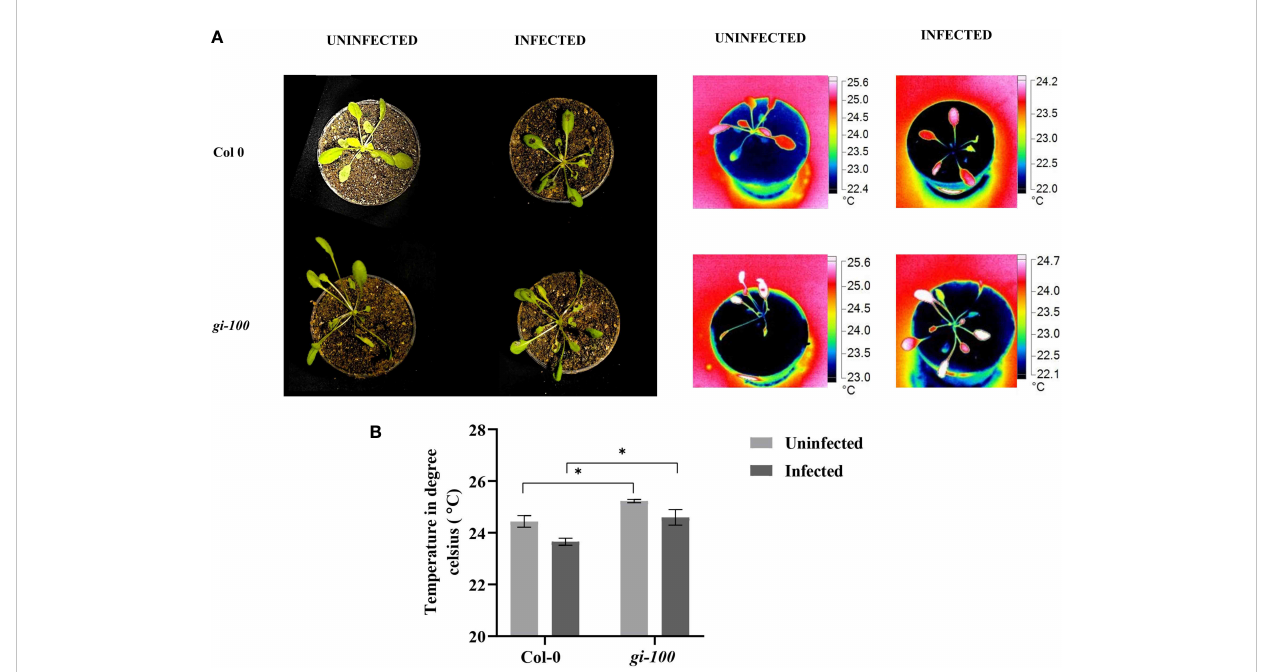
FIGURE 9 Leaf internal temperature analysis in Col-0 and gi-100 . (A) Representative images of Col-0 and gi-100 plants without and with F. oxysporum infection at 9 DPI. The pictures were taken with a FLUKE infrared camera and analyzed using the SMART VIEW software as described in Materials and methods . (B) Leaf internal temperature from a minimum of at least 10 plants of Col-0 and gi-100 was taken. Leaf surface showing highest temperatures were selectively chosen. Values are expressed as mean ± SD. Two-way analysis of variance (ANOVA) using Sidak ’ s multiple comparisons test was performed with the help of GraphPad Prism *p < 0.05.